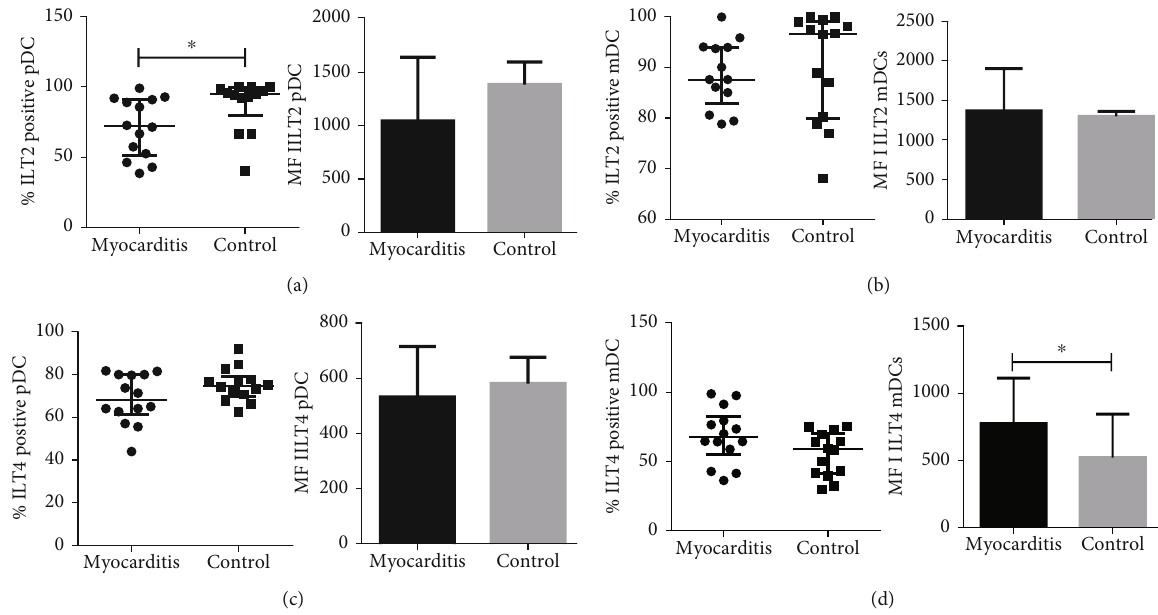
Figure 4: Expression of ILT2 and ILT4 in DCs from myocarditis and control subjects. Percentage of ILT2 (a) and ILT4 (c) in plasmacytoid DCs: LINnegHLADR+CD11c − BDCA4+ (right) and ILT2 and ILT4 expression on pDCs (MFI) (right). Percentage of ILT2 (b) and ILT4 (d) in myeloid DCs: LINneg, HLADR+CD11c+BDCA1+ (left) and expression of ILT2 and ILT4 mean fl uorescence intensity on mDCs (MFI) (right). Data are shown as median and interquartile range. ∗ p < 0 : 05 , ∗∗ p < 0 : 01 .